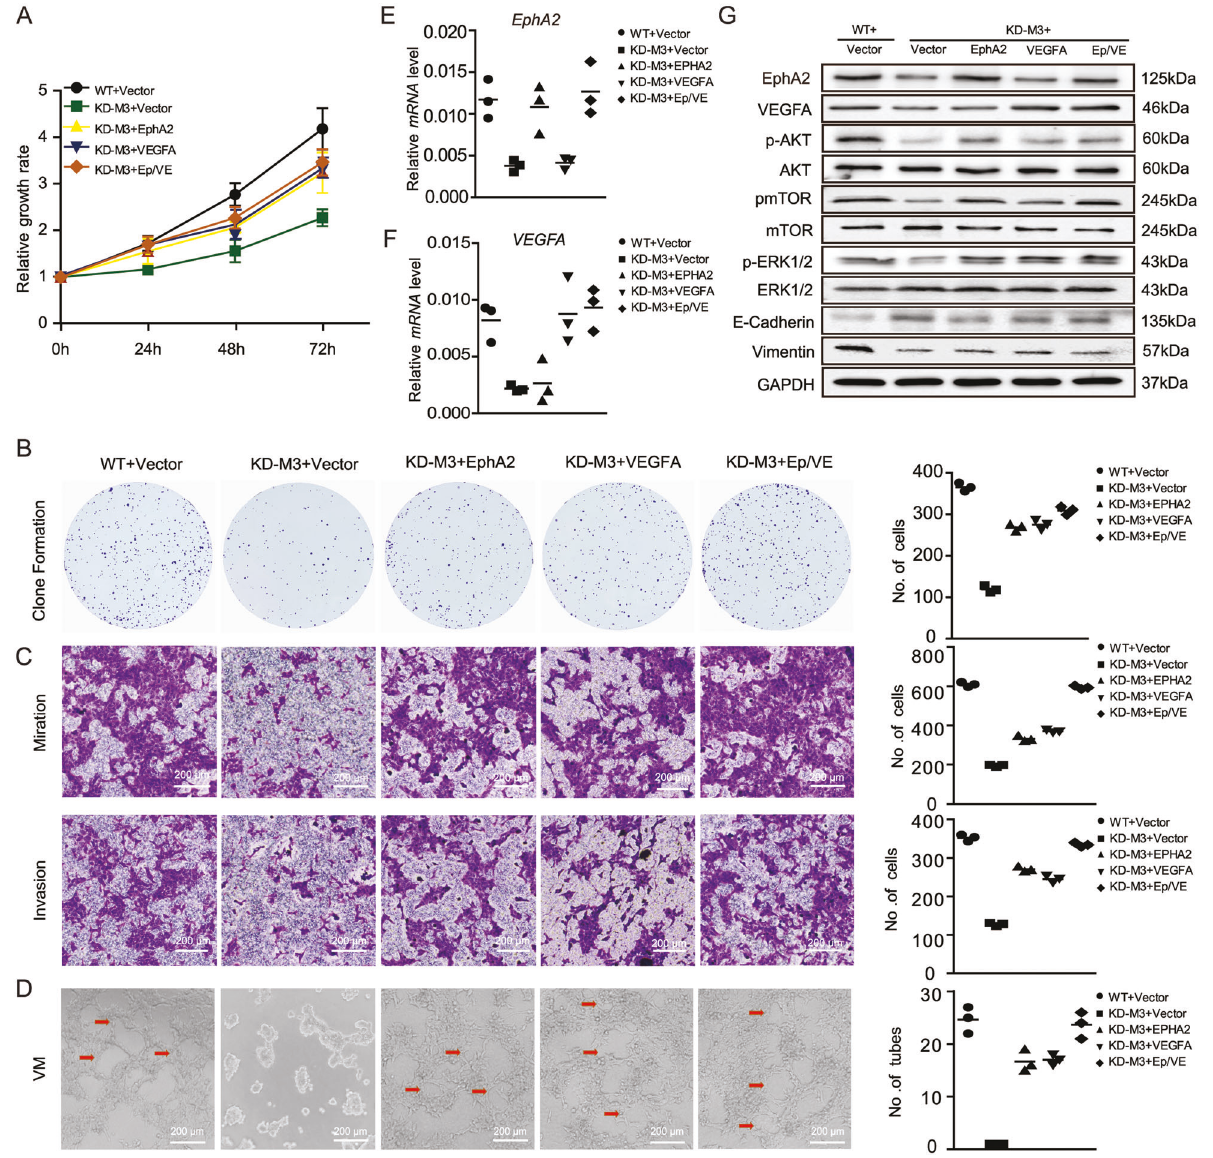
Fig. 5 METTL3 modi fi cation of EphA2/VEGFA promotes VM in CRC cells via PI3K/AKT and ERK1/2 signaling in vitro and in vivo. A Cell proliferation was measured using an MTT assay after METTL3 knockdown and EphA2/VEGFA overexpression. B Migration and invasion ef fi ciency elucidated by transwell assay. C Summary graphs showing the numbers of colonies counted. D Representative images of tube formation by HCT116 cells and METTL3-deletion cells overexpressing EphA2/VEGFA after 48 h. Scale bars, 200 µm. E – G EphA2 expression detected by qRT-PCR and western blotting after successful overexpression of EphA2 and VEGFA. H Effect of METTL3 deletion on the AKT/ ERK1/2 signaling pathway. p values were calculated using the t test from three independent experiments. ** p < 0.01, *** p < 0.001. WT wild- type cells, KD-M3 METTL3 knockdown, Vector, cells transfected with GV230 empty